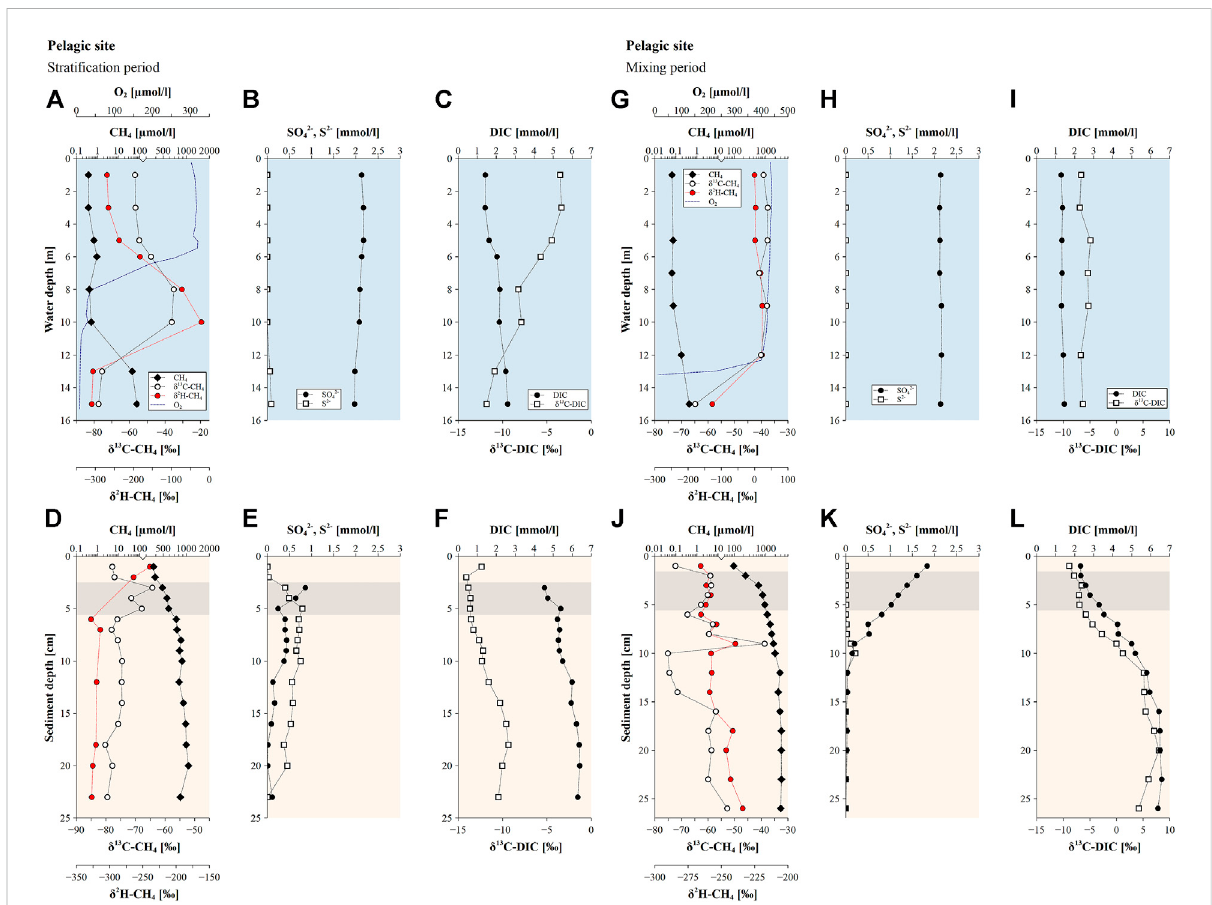
FIGURE 3 Methane (CH 4 ) concentrations, δ 13 C-CH 4 and δ 2 H-CH 4 values along with sulfate, sul fi de, dissolved organic carbon (DIC) concentrations and δ 13 C-DIC values observed at the pelagic site during (A – F) the strati fi cation period (July 2020) and (G – L) the mixing period (March 2021). Blue graph background colors indicate pro fi les in the water column, orange background colors show pro fi les of sediment cores and grey highlighted sediment depths indicate the occurrence of the